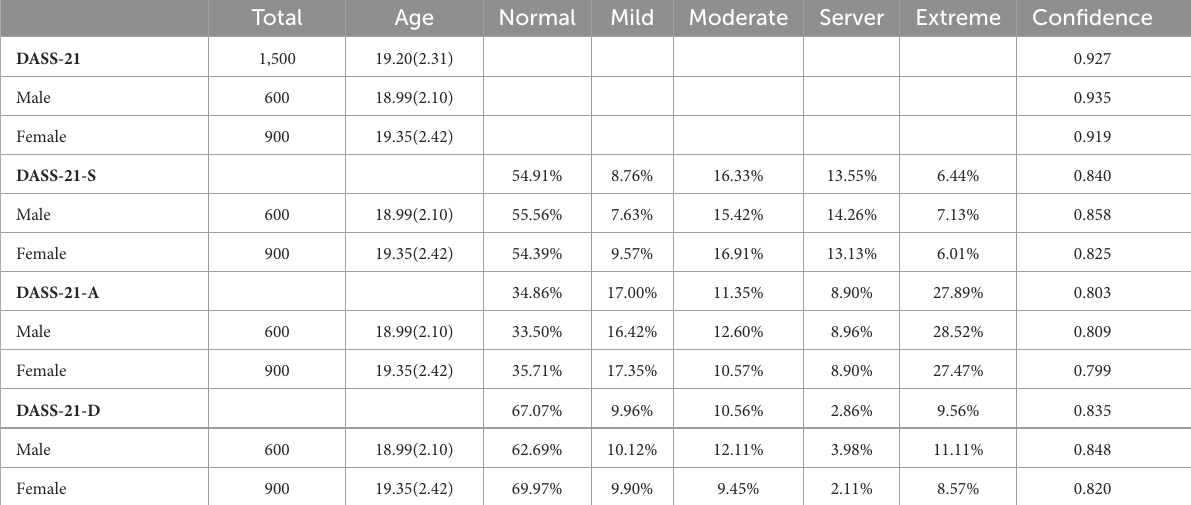
TABLE 1 Interactive DASS-21 descriptive